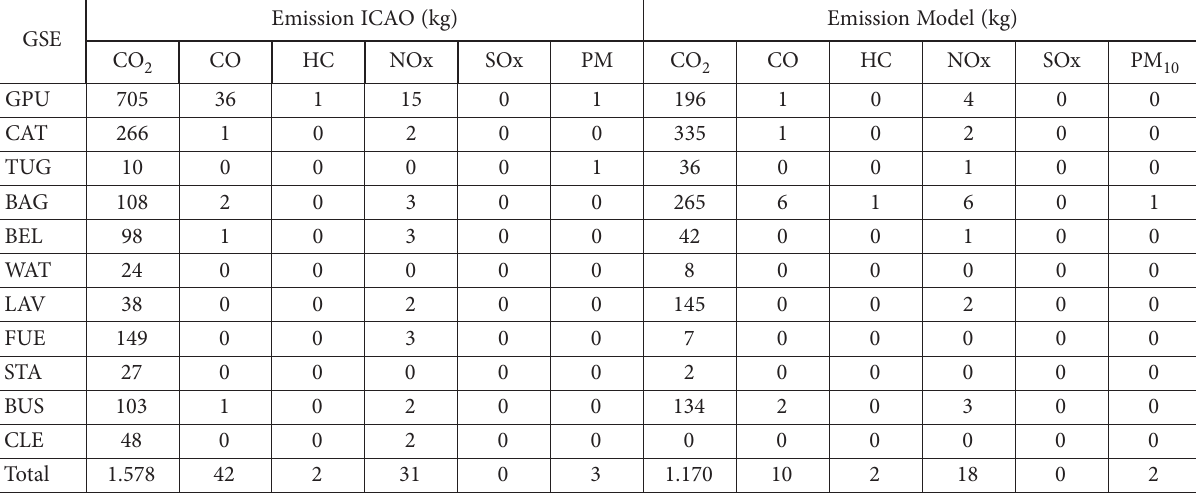
Table C1. Comparison between ICAO methodology and the model (source: